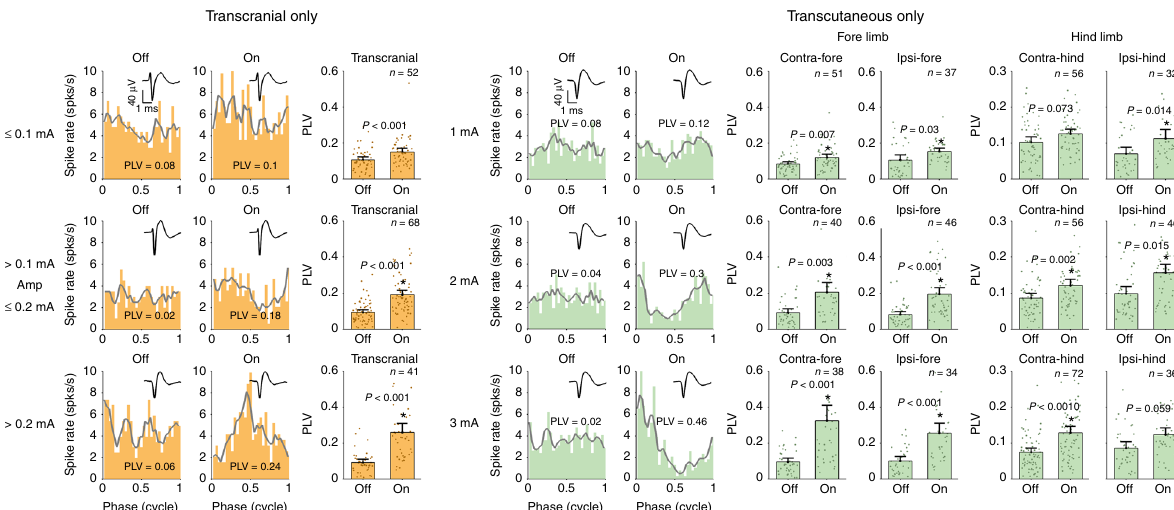
Fig. 3 Effect of transcranial- and transcutaneous-only stimulation on neural entrainment. The rows show the effect of increasing stimulation amplitude on phase locking value (PLV). The transcranial-only data are grouped into three amplitude ranges: LOW ( ≤ 0.1 mA), MEDIUM (>0.1 mA, but ≤ 0.2 mA), HIGH (>0.2 mA). While the transcutaneous-only data were collected at three fi xed amplitudes: LOW (1 mA), MEDIUM (2 mA), HIGH (3 mA). Entrainment increased with increasing amplitude (linear model followed by one-sided Wilcoxon sum rank). As in Fig. 2, the PLV values quantifying the amount of neural entrainment are reported on the example cycle histograms. The bar graphs compare the mean PLV for stimulation OFF and ON for each amplitude condition. Error bars show the con fi dence intervals. A star indicates that there was a signi fi cant increase in neural entrainment from stimulation OFF to ON for that particular condition. For transcutaneous-only stimulation, four different electrode con fi gurations were tested: contralateral (to the 32-channel recording probe) fore, contralateral hind, ipsilateral fore and ipsilateral hind. The fore limb electrode con fi gurations caused more neural entrainment than the hind limb con fi gurations. In general, we found that transcutaneous-only stimulation produces similar patterns of neural entrainment to transcranial-only stimulation. (Wilcoxon signed rank test, one-sided, Bonferroni corrected for transcranial and